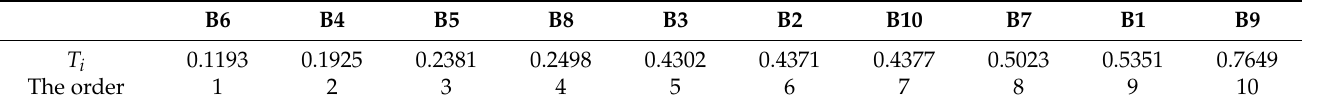
Table 8. Closeness degree and ranking results of evaluation indexes.